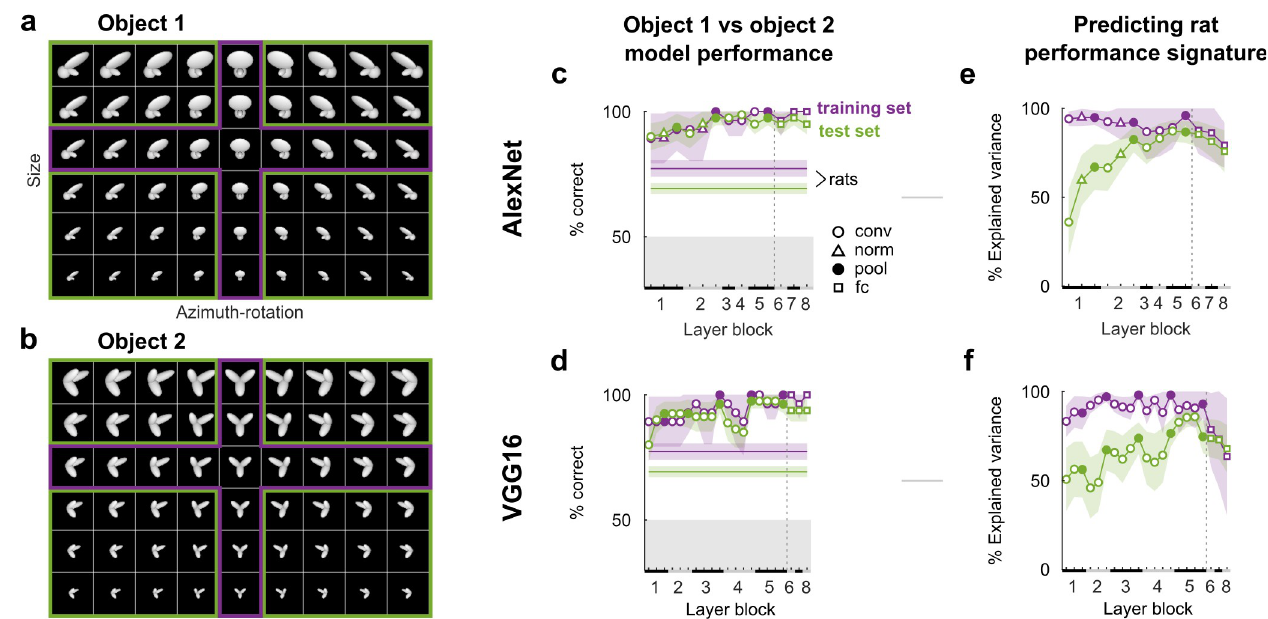
Fig 2. The first DNN layers account for generalization performance across a range of object transformations, but higher layers explain more variance in the transformation-level behavioral performance signature in Zoccolan et al. [1]. ( a , b ) The full sets of size and azimuth-rotation combinations of the two objects used in the behavioral task. For copyright reasons we do not show the stimuli from the original paper, but images of similar objects created in Blender 2.91 for illustrative purposes only. For the model we did use the originals from [1]. Rats were first trained on a subset of 14 of these transformations (purple) and subsequently asked to generalize to the remaining 40 novel combinations (green). ( c , d ) Average percentage correct discrimination of object 1 and object 2 by models incorporating increasingly more DNN layers of AlexNet (c) and VGG16 (d) (the X-axis indicates the highest DNN layer). Each model’s decoder layer was first trained on the same object transformations as the rats, after which performance was evaluated on these trained transformations (purple) as well as the untrained transformations (green). Horizontal lines indicate the average behavioral performance across rats reported by Zoccolan et al. [1]. Black and grey bars on the X-axis indicate layer blocks and markers indicate layer types (see legend insert); the division between convolutional and fully connected layer blocks is indicated by a dashed line. ( e , f ) Percentage variance in performance across stimuli explained by each DNN layer (estimated by a linear mapping fit on the data and stimuli of the training set only) from AlexNet (e) and VGG16 (f). Same conventions as in (c,d). All error bounds are 95% confidence intervals calculated using Jackknife standard error estimates (resampling size and azimuth-rotation combinations).